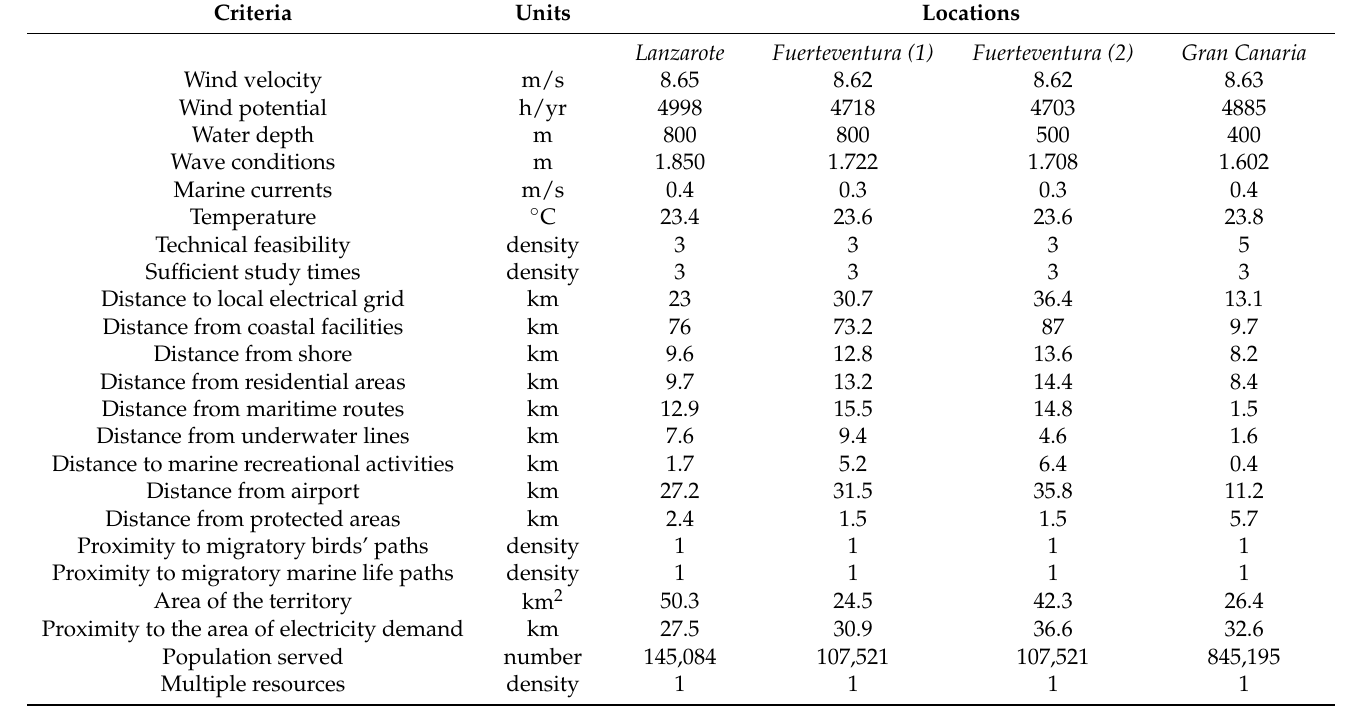
Table 5. Evaluation parameters for the Canary Islands locations.